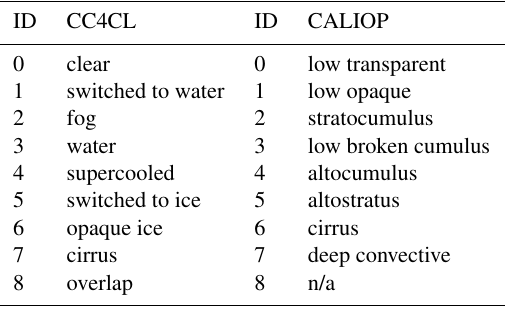
Table 3. Linear regression coefficients between collocated AVHRR and MODIS/AATSR channels.